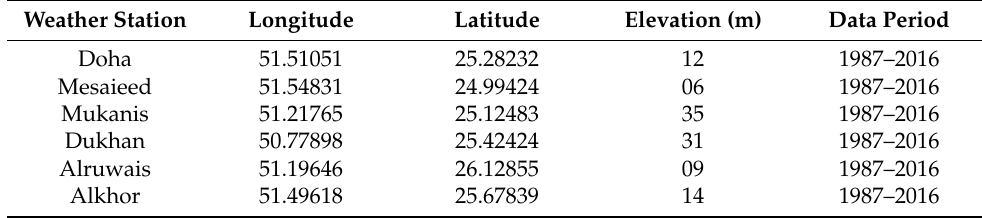
Table 1. Location of the weather stations and dataset